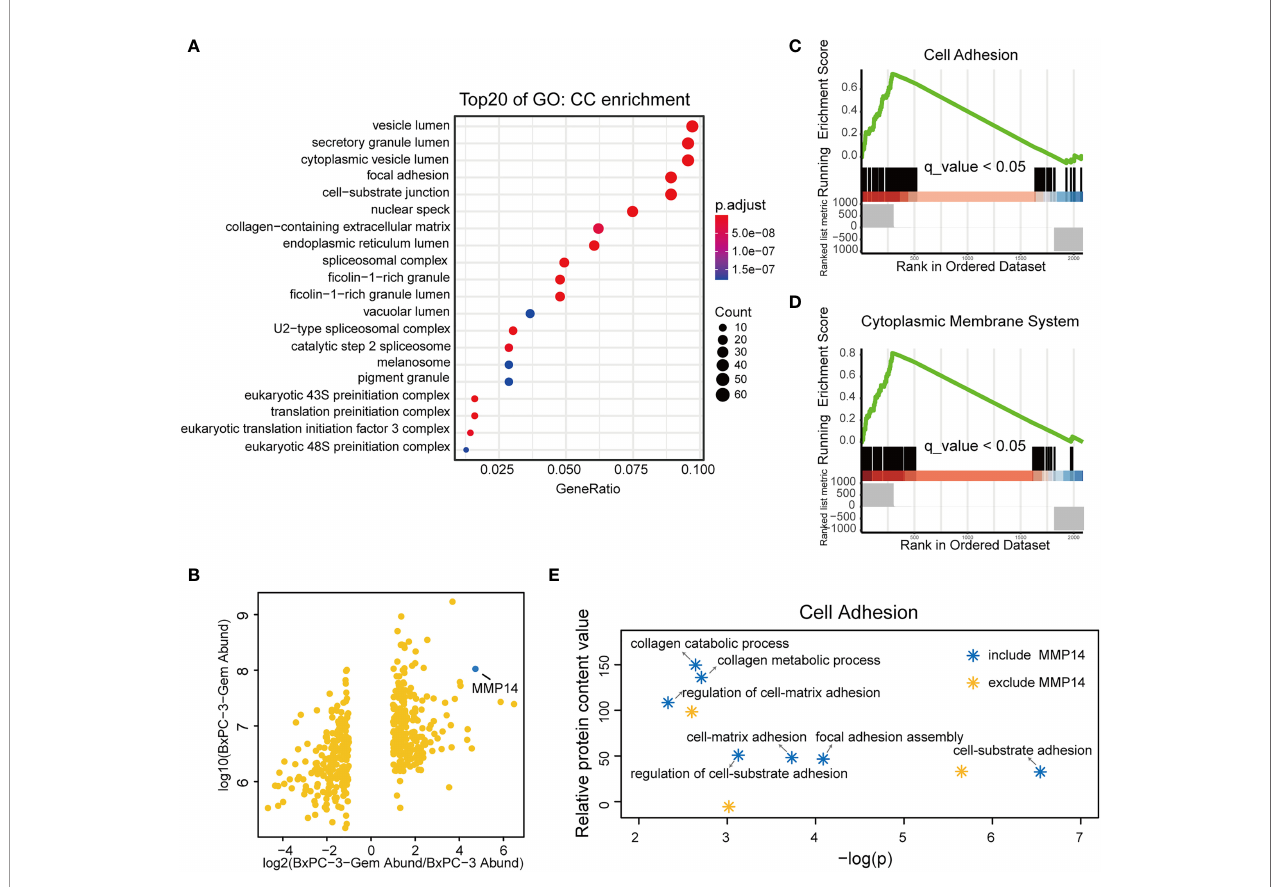
FIGURE 1 | MMP14 was identi fi ed as the major differentially secreted protein by comparative secretome. (A) Gene Ontology (GO) functional enrichment (Cell Components, CC) for differential proteins in the conditioned medium of BxPC-3-Gem in relative to parental cells. Top 20 functions were exhibited in the plot. (B) Scatter plot of differentially secreted proteins in fold change of BxPC-3-GEM vs. BxPC-3 cells (x-axis) against BxPC-3-GEM cells (y-axis). The dot representing MMP14 was shown (blue dot). (C, D) GSEA analysis showed that differential proteins in the conditioned medium of BxPC-3-Gem vs BxPC-3 cells were enriched in cell adhesion system (C) and cytoplasmic membrane system (D) (q < 0.05, Bonferroni method; rank ordered by ratio of BxPC-3-Gem/BxPC-3). (E) Point plots of molecular functions involved in cell adhesion system. Function pathways included MMP14 (blue stars) or excluded MMP14 (orange star) in cell adhesion system were